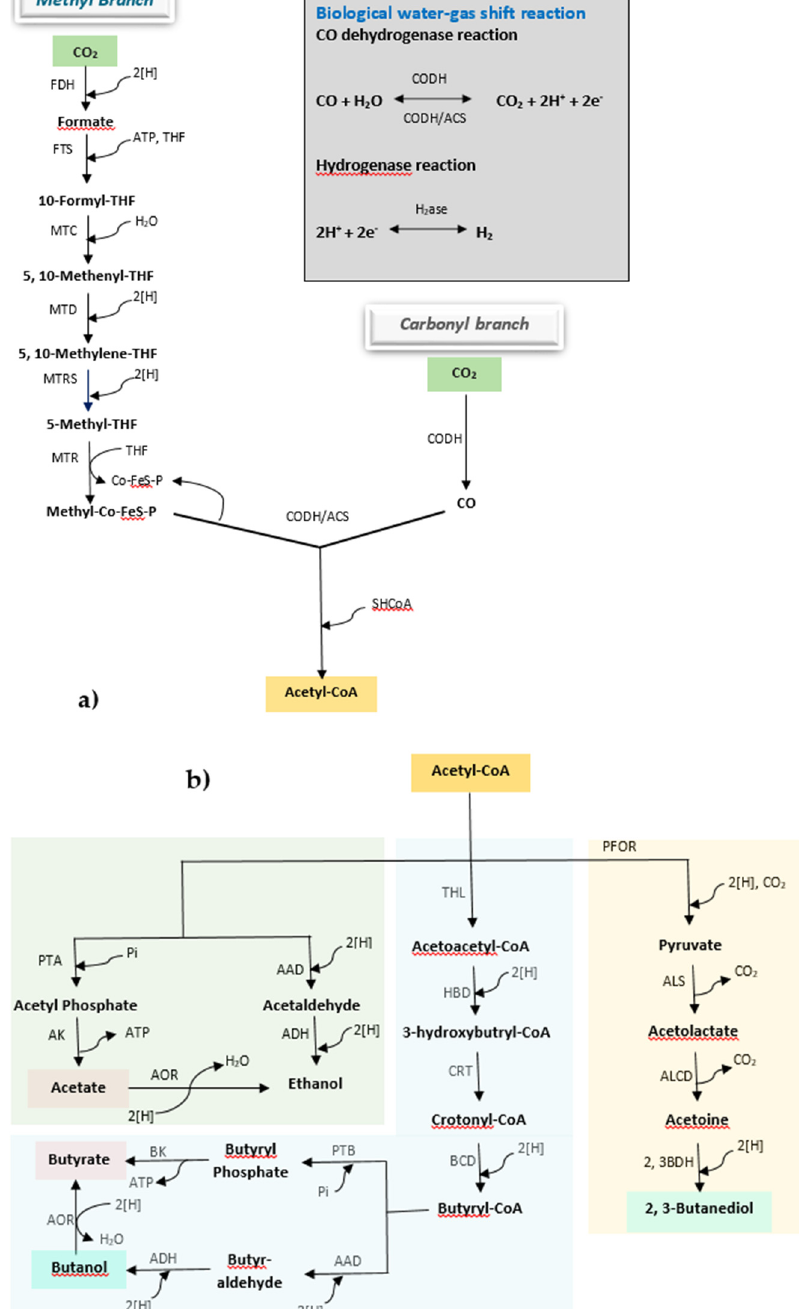
Figure 2. Metabolic processes for syngas conversion to diverse products through the Wood–Ljungdahl pathway (modified from Ciliberti et al. (2020)) [24]. ( a ) Conversion of syngas to acetyl-CoA and ( b ) conversion of acetyl-CoA to fermentation products. Abbreviations: AAD, alcohol/aldehyde dehydrogenase; ACS, acetyl-CoA synthase; ADH, alcohol dehydrogenase; AK, acetate kinase; ALDC, acetolactate decarboxylase; ALS, acetolactate synthase; AOR, aldehyde:ferredoxin-oxidoreductase; BCD, butyryl-CoA dehydrogenase; BK, butyrate kinase; CODH, CO dehydrogenase; Co-Fes-P, corri- noid iron-sulfur protein; CRT, crotonase; FDH, formate dehydrogenase; FTS, formyl-THF synthetase; HBD, 3-hydroxybutyryl-CoA dehydrogenase; HYA, hydrogenase; MTC, methenyl-THF cylcohy- drolase; MTD, methylene-THF dehydrogenase; MTR, methyltransferase; MTRS, methylene-THF reductase; PFOR, pyruvate:ferredoxin oxidoreductase; PTA, phosphotransacetylase; PTB, phospho- transbutyrylase; THF, tetrahydrofolate; THL,